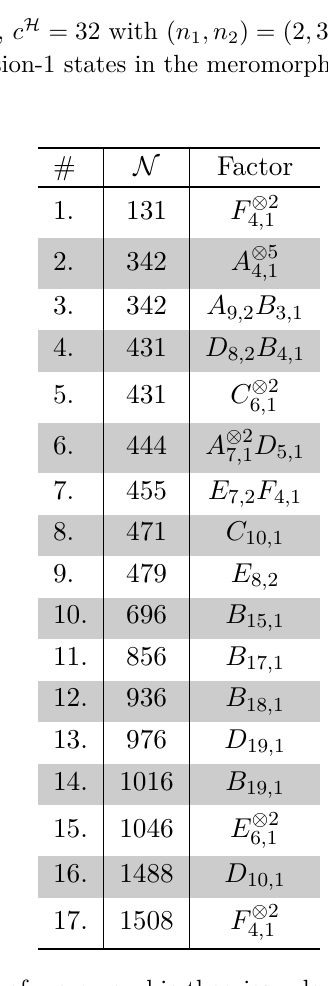
Table 17. List of meromorphic theories ruled out by table